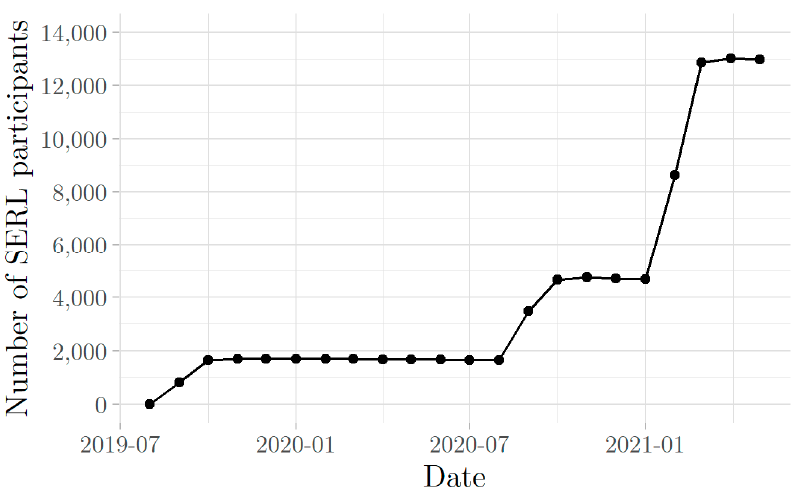
Figure 3. Number of active SERL participants over time.